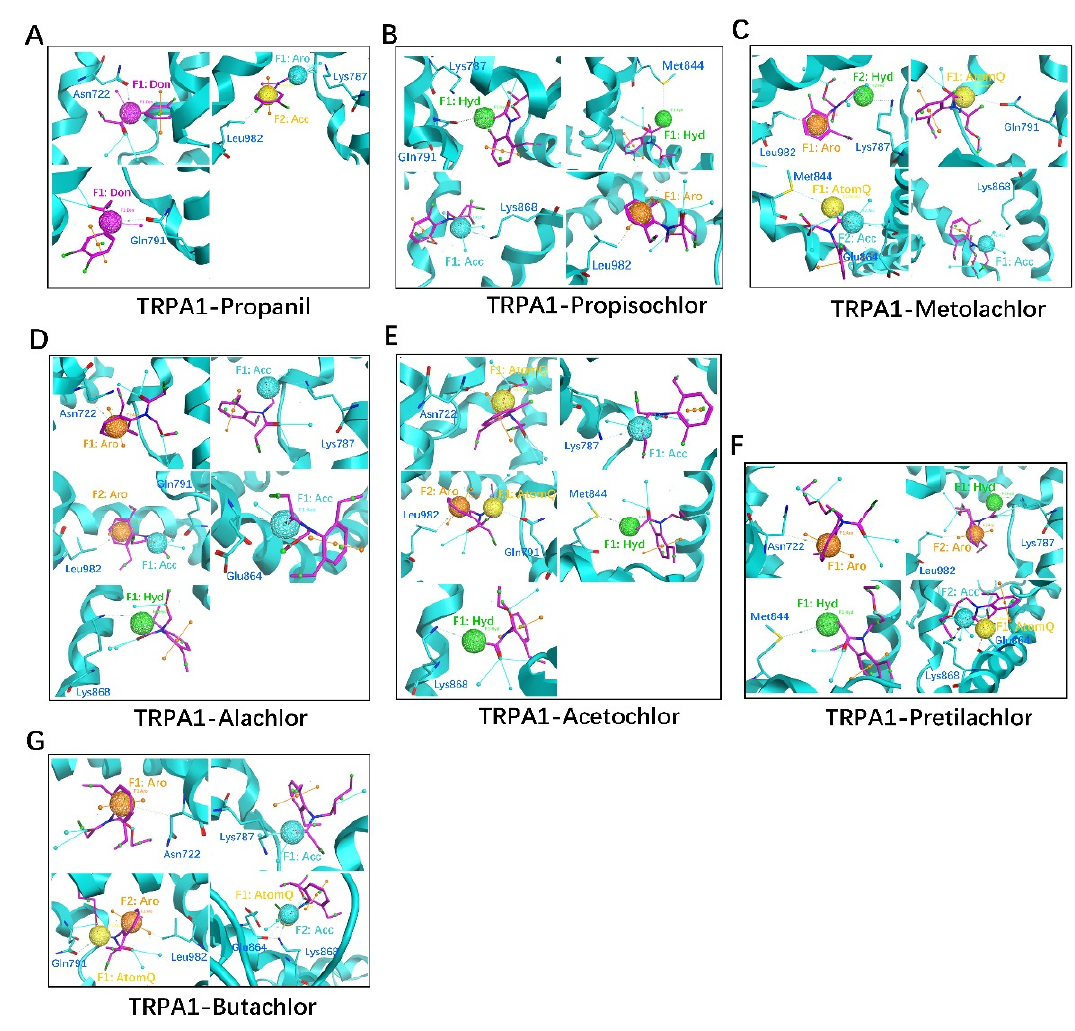
Figure 5. Interactions between hTRPA1 and AHs determined by molecular docking simulations. ( A ) Propanil, ( B ) Propisochlor, ( C ) Metolachlor, ( D ) Alachlor, ( E ) Acetochlor, ( F ) Pretilachlor, ( G ) Bu- tachlor.